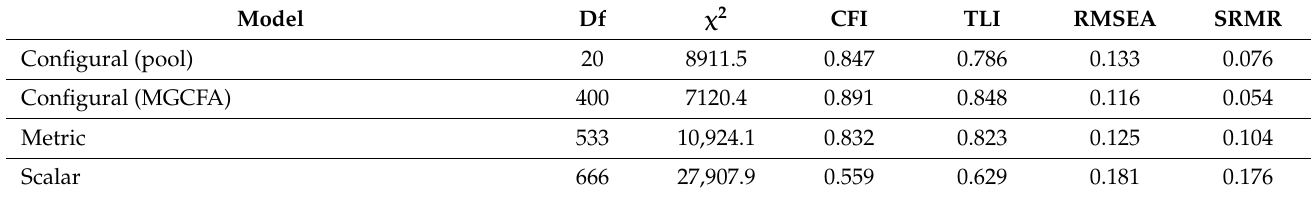
Table 1. Fit indices for models that test configural, metric and scalar equivalent